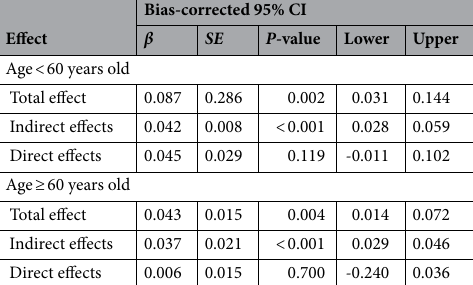
Table 5. The mediation model of depressive symptoms stratified by age a . a The effect adjusted the covariates include gender, education, marital status, residency, smoking, drinking, BMI, hypertension, dyslipidemia, and diabetes or high blood sugar.